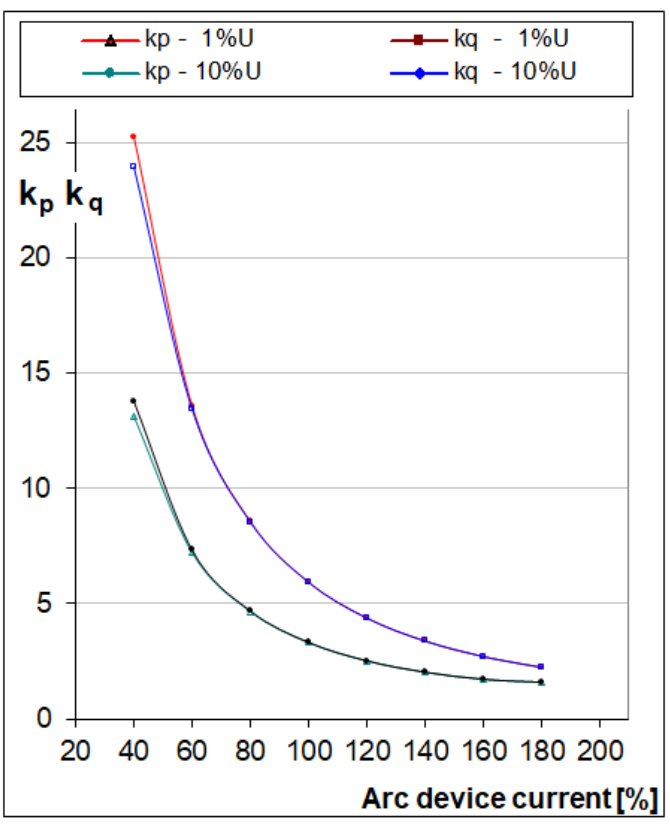
Figure 5. Changes in the coefficients of power–voltage characteristics as a function of the current consumed by the arc device.